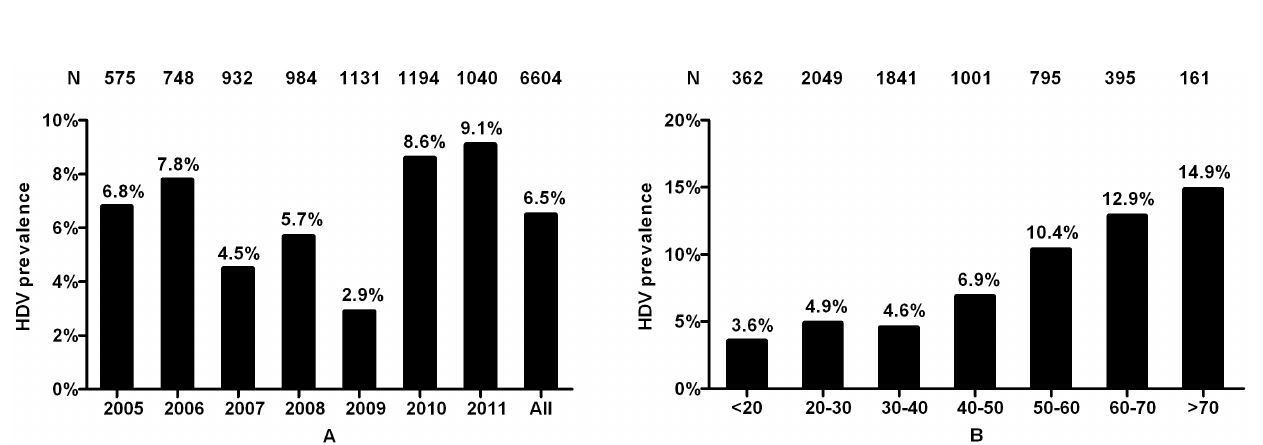
Fig. 2. Distribution of HDV stratified by years and age. (A) Distribution of HDV stratified by years. The prevalence of HDV declined from 6.8% in 2005 to 2.9% in 2009, but then increased to 9.1% in 2011. The prevalence of HDV was 6.5% among all patients. (B) Distribution of HDV stratified by age. The prevalence of HDV correlated with age, with the lowest (3.6%) in patients under 20 years old and the highest (14.9%) in patients over 70 years old. Patients over 50 years old have higher frequencies of HDV compared to those under 50 (11.7% vs. 5.1%, P , 0.001).